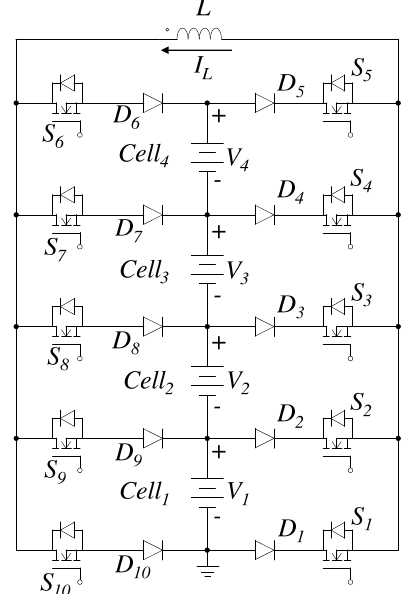
Figure 22. Single-inductor equalizer